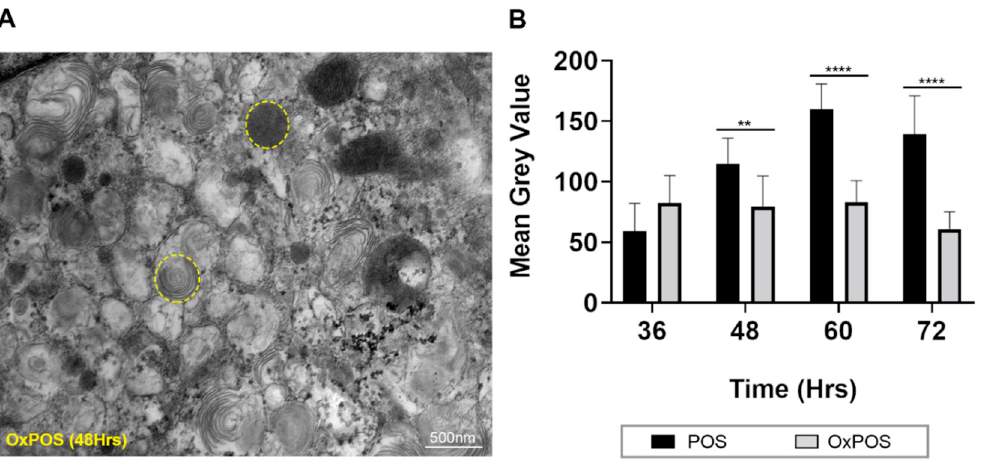
Figure 5. Quantification of cargo content within late compartments as a function of time. To assess whether POS or OxPOS cargos were being degraded or not, trafficking vesicles were demarcated as regions of interest (ROI), and their luminal content quantified by measuring the mean greyscale value. A higher electron density is represented by a lower greyscale value. ( A ) A representative electron micrograph from RPE cells exposed to OxPOS after 48 h. Example ROIs in micrograph show vesicles with distinct cargos (dashed yellow circles). Scale bar corresponds to 500 nm. ( B ) The cargo content in trafficking vesicles were quantified in blinded electron micrographs, which revealed increasing greyscale values within ROIs of POS-trafficking vesicles. By contrast, ROIs with OxPOS showed no appreciable change throughout the time course. Data from a minimum of n = 10 fields/per time point. Statistical comparisons using a two-way ANOVA followed by Sidak’s multiple comparison test, where significant differences are indicated as p ≤ 0.01 (**) and p ≤ 0.0001 (****).